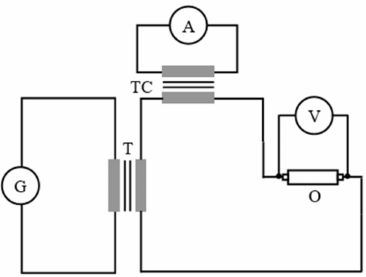
Figure 5. Temperature-rise test layout (caption: G—generator, T—step-up transformer, TC—current transformer, A—ammeter, O—fuse, V—voltmeter).